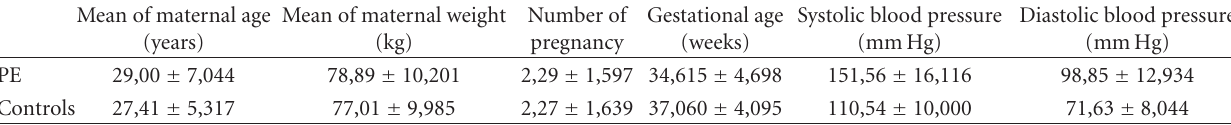
Table 1: The clinical characteristics of the study population and controls.